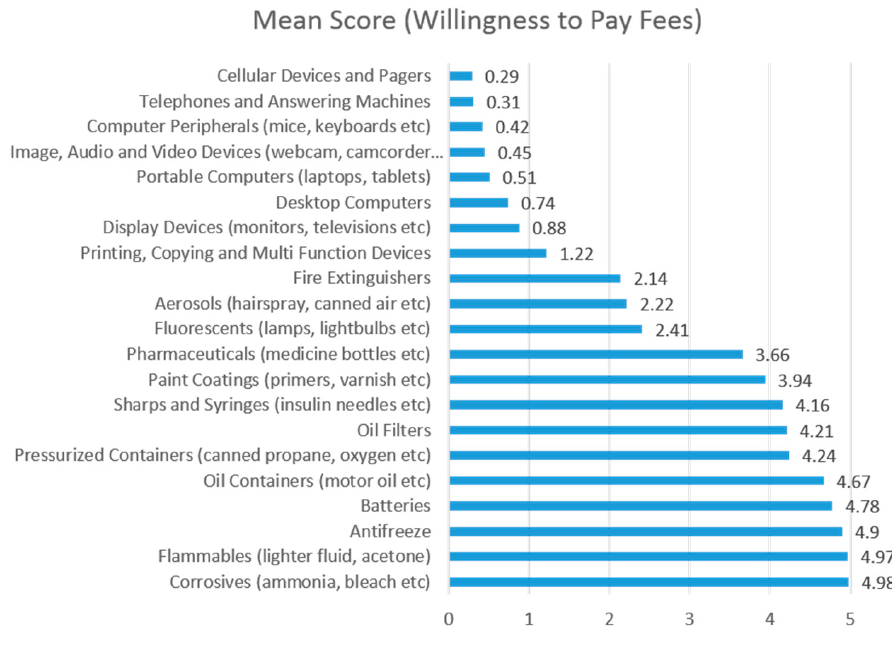
Figure 1. Willingness to Environmental Handling Fees.